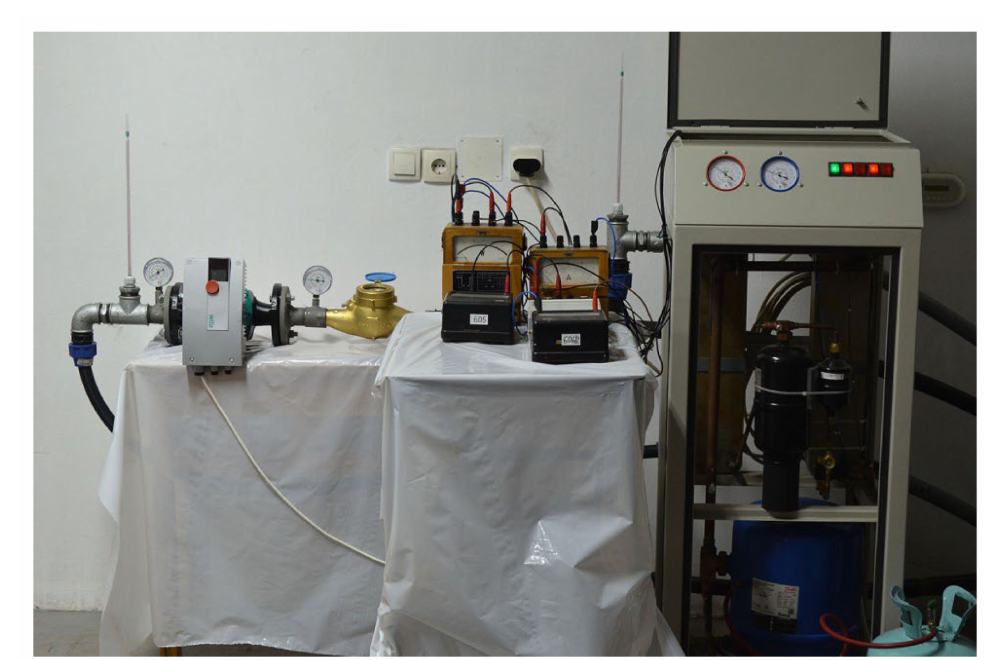
Figure 4. Photo of the measurement system with the heat pump.